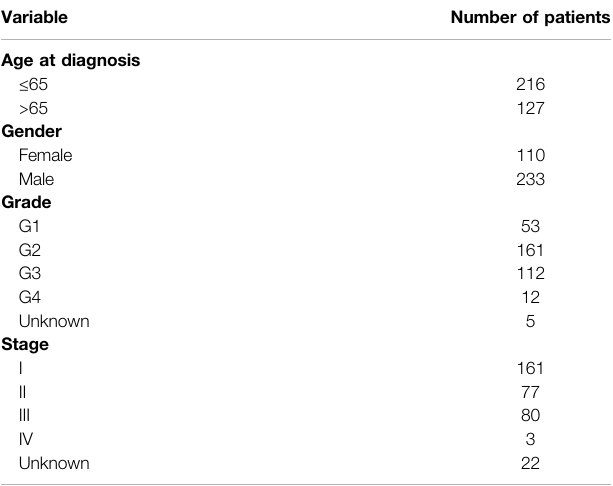
TABLE 1 | The clinical information of hepatocellular carcinoma patients in the whole cohort.